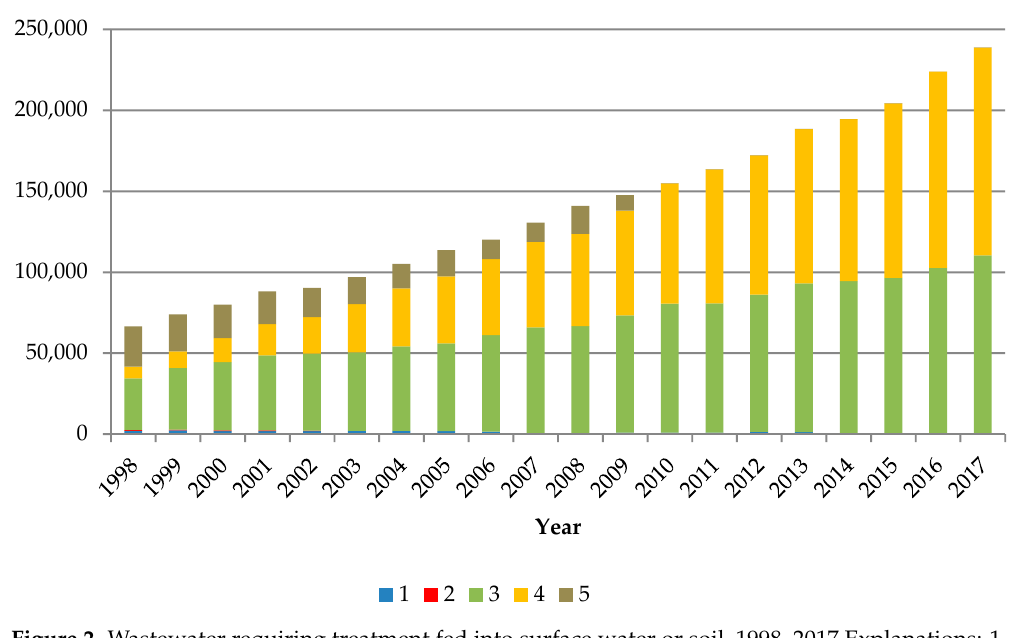
Figure 2. Wastewater requiring treatment fed into surface water or soil, 1998–2017 Explanations: 1 - mechanically treated wastewater; 2 - chemically treated wastewater; 3 - biologically treated wastewater; 4 - treated wastewater with increased nutrient removal; 5 - raw sewage.